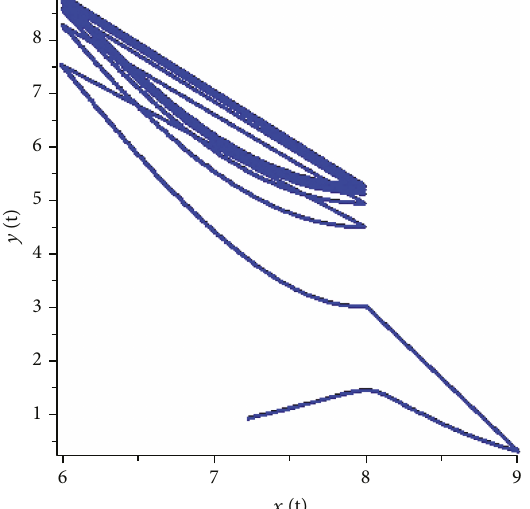
Figure 14: Structure diagram in R + h 2 > m 2 .